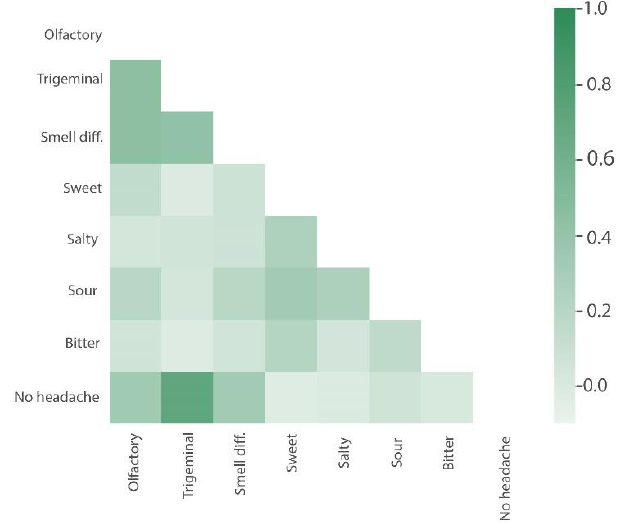
Figure 8. Correlations between smell sensitivity, differentiation ability, taste sensitivity and differentiation, and the prevalence of headaches.